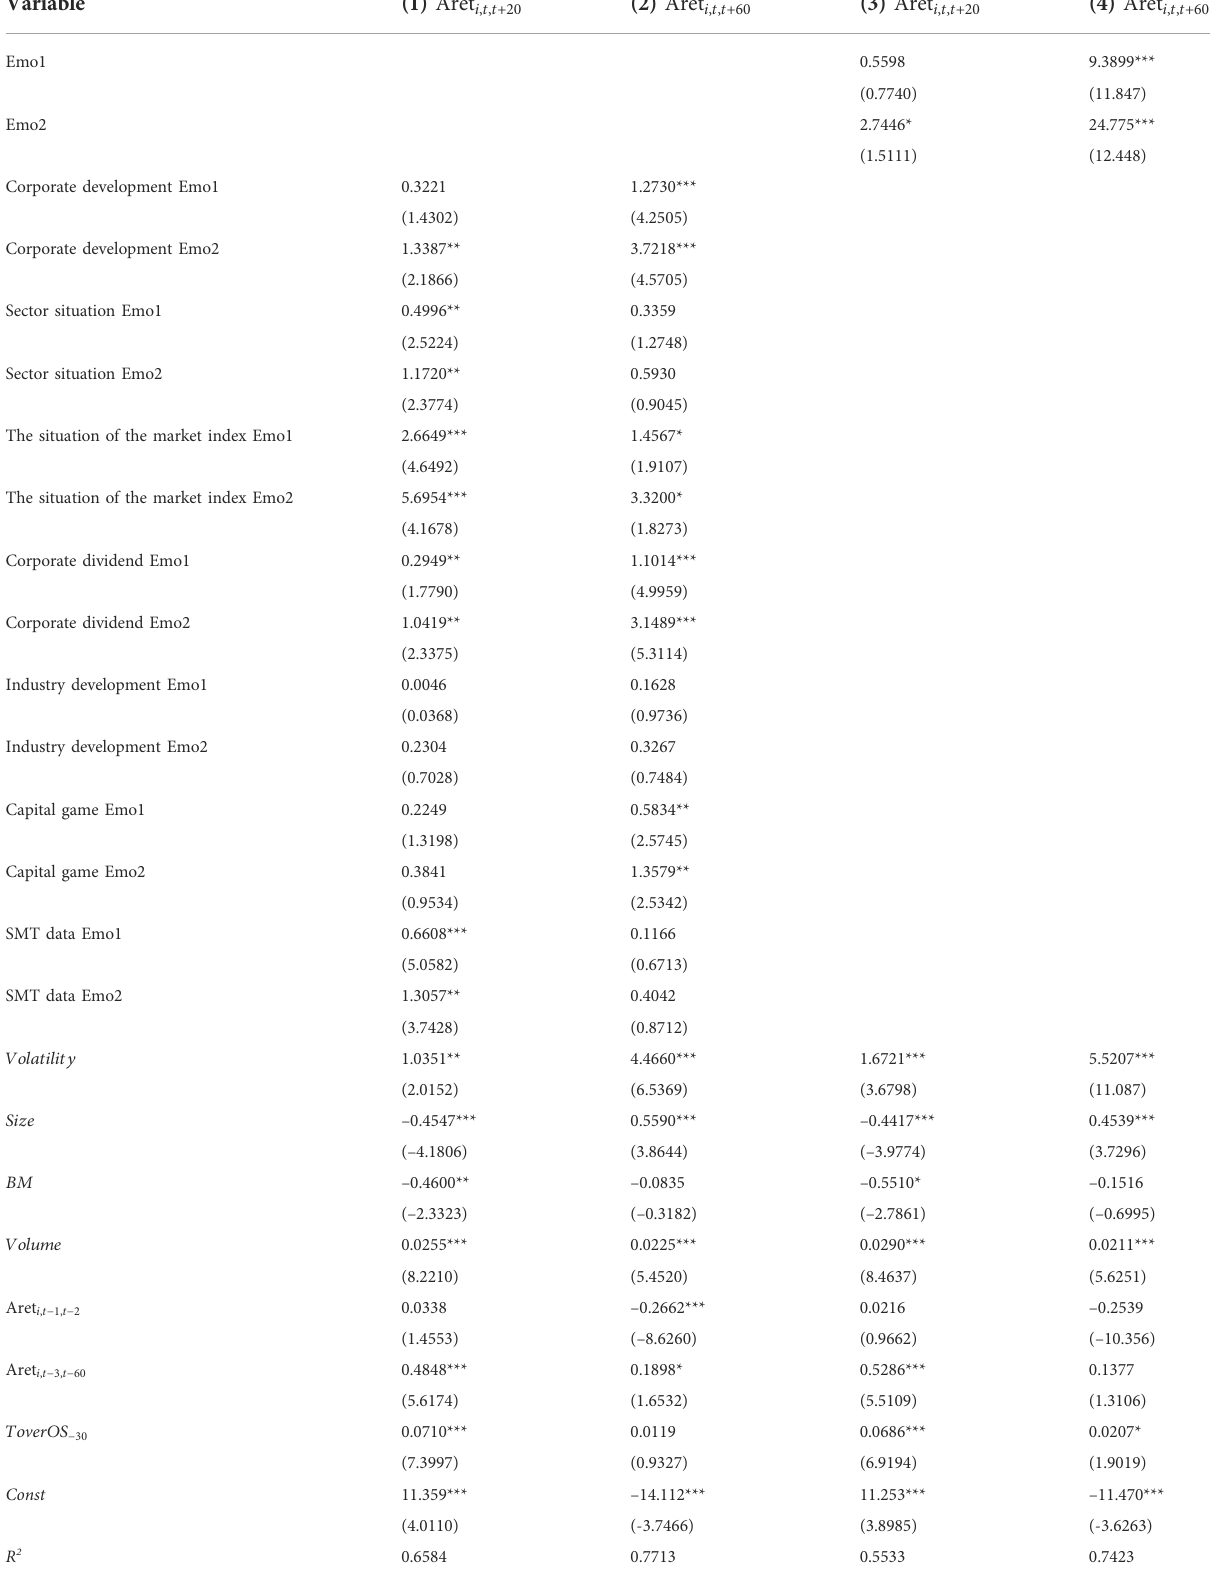
TABLE 4 Excess return and regression result of sentiment